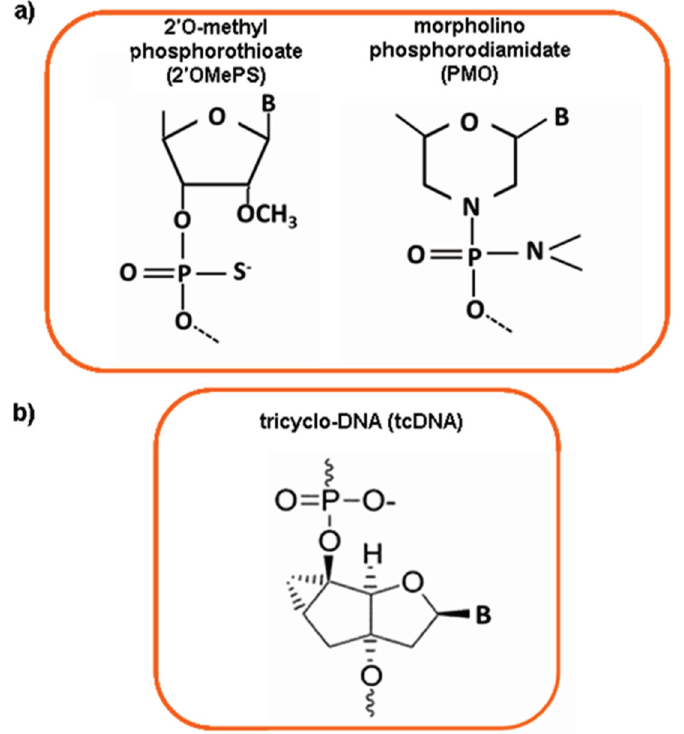
Figure 2. Chemical structure of different antisense oligonucleotide molecules. ( a ) 2 ′ -O- methyl phosporothioate antisense (2 ′ OMePS) and morpholino phosphorodiamidate oligomer (PMO); ( b ) tricyclo-DNA (tcDNA)